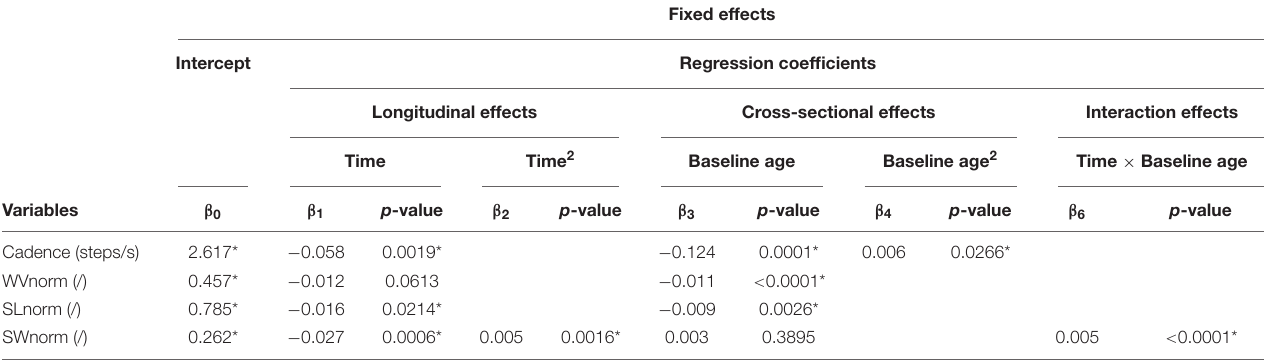
TABLE 3 | Results of linear mixed effect models with spatiotemporal parameters as responses in children with